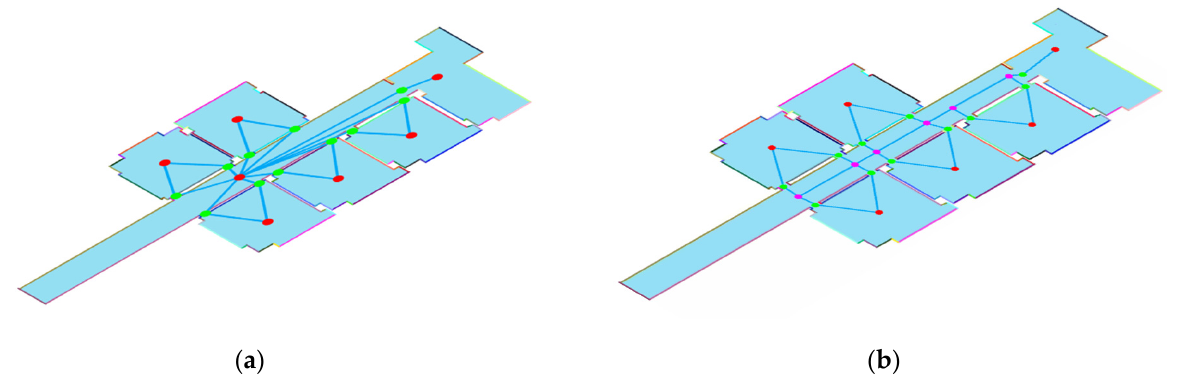
Figure 10. Corridor navigation network generation and adjustment. The purple dots are corridor nodes. The red dots and green dots are abstract nodes. The thick blue lines indicate the connection relationship between nodes. ( a ) represents the initial navigation network. ( b ) represents the corridor node optimized navigation